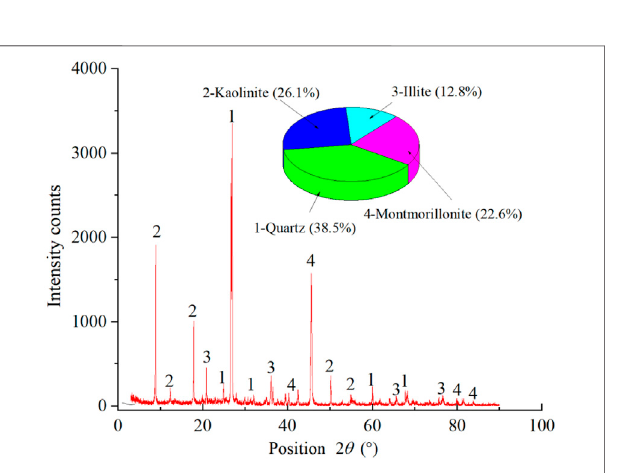
FIGURE 3 | Minerals contents of the sandy mudstone by XRD